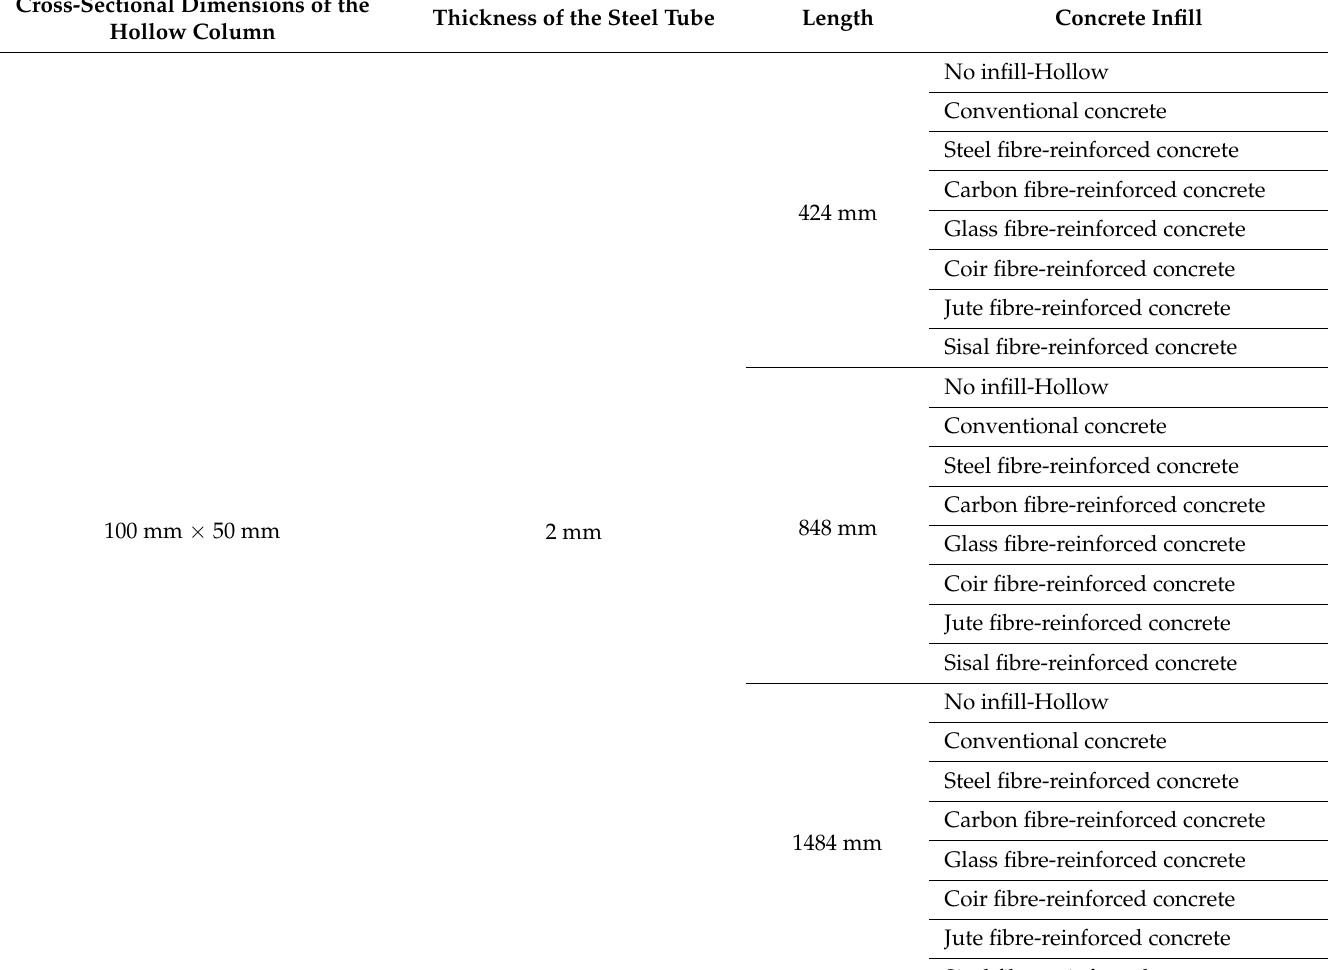
Table 1. Specimen details of cold-formed steel tubular columns. Cross-Sectional Dimensions of the Hollow